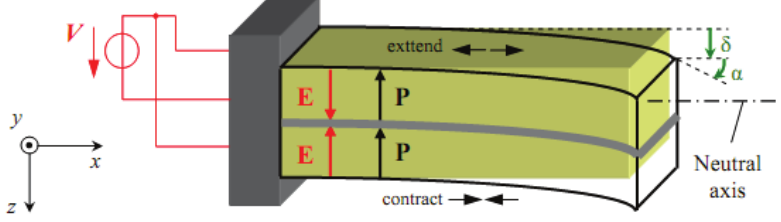
Figure 2. Basic intensive parameters of bimorph actuators after applying electric field.